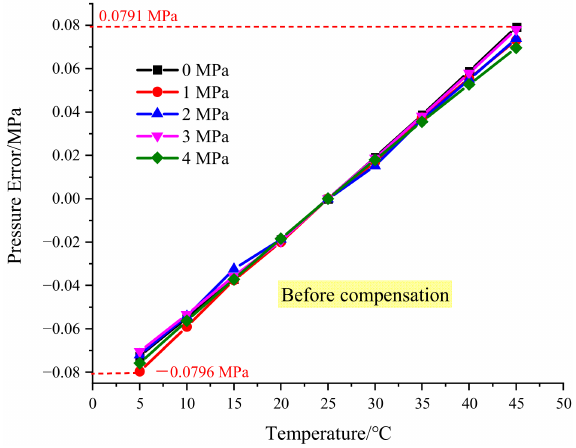
Figure 5. Test error before temperature